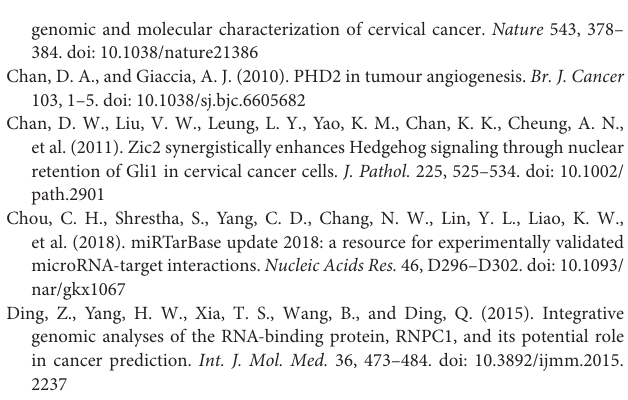
FIGURE S3 | Schoenfeld residual plots for hsa-miR-335-3p and hsa-miR-532-5p. FIGURE S4 | The first row shows the densities, the second the distribution function and the last row the local and tail area-based false discovery rates of genes. TABLE S1 | MCA of RNA-NPI and miRNA-NPI. TABLE S2 | MCA of RNA-NPI and gene-NPI. TABLE S3 | MCA of the transcriptomic signature in non-mutated CESC samples. TABLE S4 | UCA of previously identified prognostic genes and miRNAs. TABLE S5 | MCA of previously indentified prognostic genes and miRNAs. TABLE S6 | MCA of RNA-NPI and